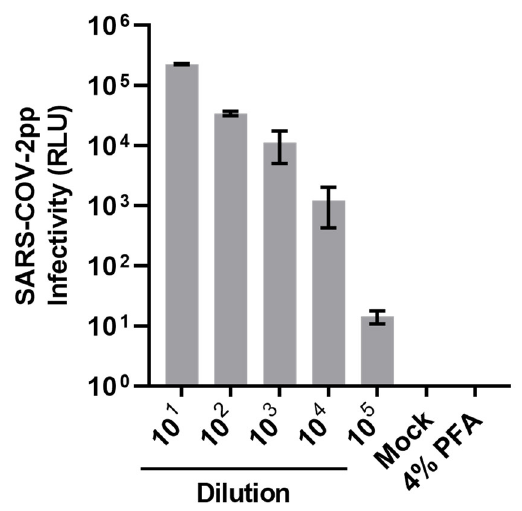
Figure 1. Titration of SARS-CoV-2 pseudoparticles (SARS-CoV-2pp). The serial dilution of SARS-CoV-2pp stock was used to infect Huh-7 cells for 2 h. Viral infectivity was measured by luciferase reporter activity (relative light units; RLU) after 72 h incubation. Data shown are collected in triplicate and expressed as mean ± standard deviation (SD). Paraformaldehyde (PFA; 4%) fixed cells infected with 10 × diluted SARS-CoV-2pp stock was included as a negative control.